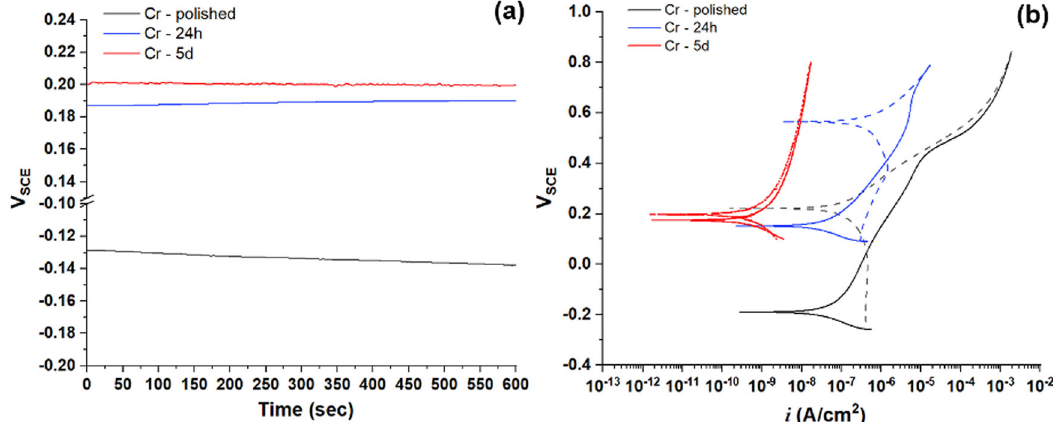
Fig. 8 Electrochemical corrosion results for as-polished versus thermally oxidized chromium. a Open circuit potential and b cyclic potentiodynamic polarization plot of as-polished and thermally oxidized chromium tested in 0.1 M borate buffer solution (pH 9.3) deaerated with N 2 . In Fig. 9b, the solid line (-) indicates the forward scan and the dash line ( – ) indicates the reverse